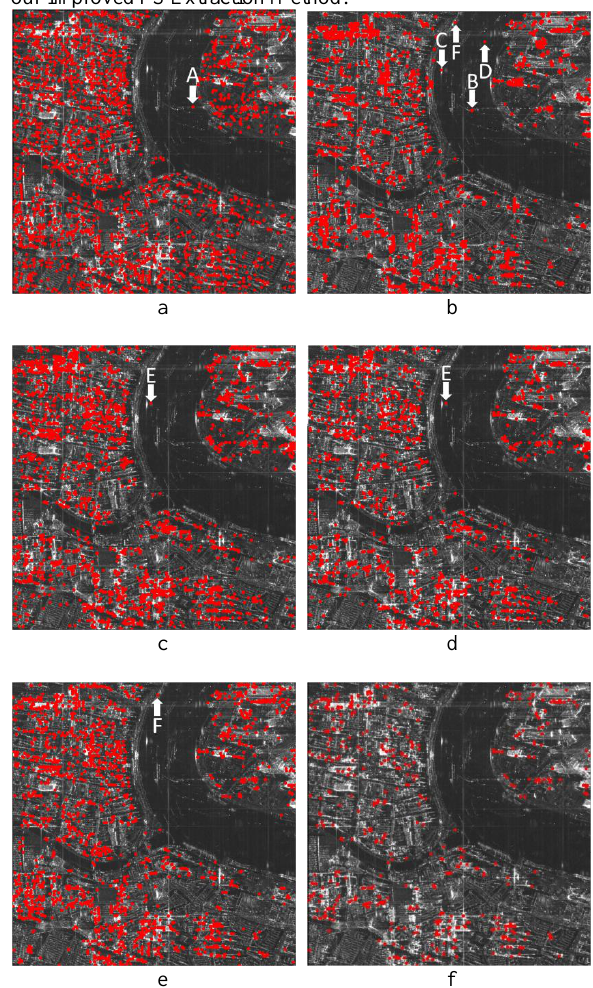
Figure 3. The results of six PS selection methods (a. Coherence coefficient threshold method b. Amplitude threshold method c. Dispersion of Amplitude method d.